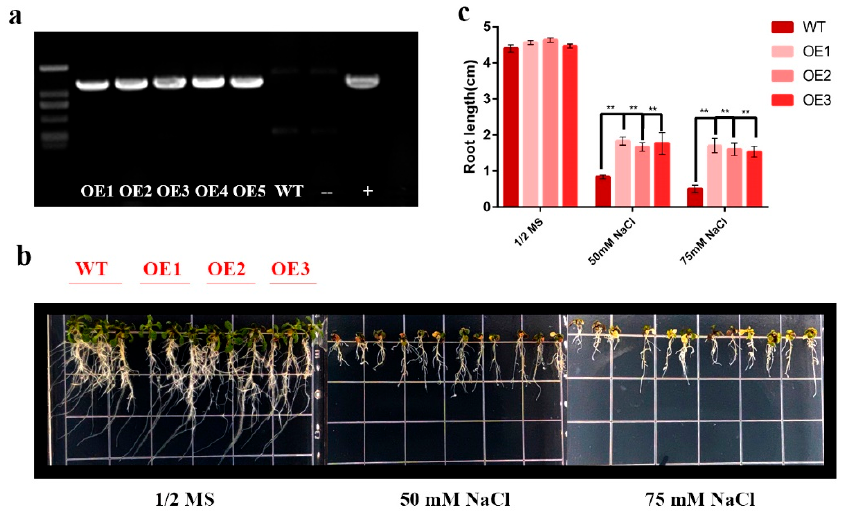
Figure 7. Salt tolerance assay of HhNAC54 -overexpressed A. thaliana plants. ( a ) Agarose gel elec- trophoresis profile for the expression of HhNAC54 . ( b ) Comparison between root lengths of WT and transgenic A. thaliana under different concentrations of NaCl. ( c ) Statistic histogram of root length in WT and transgenic A. thaliana under different concentrations of NaCl (** p <0.01).